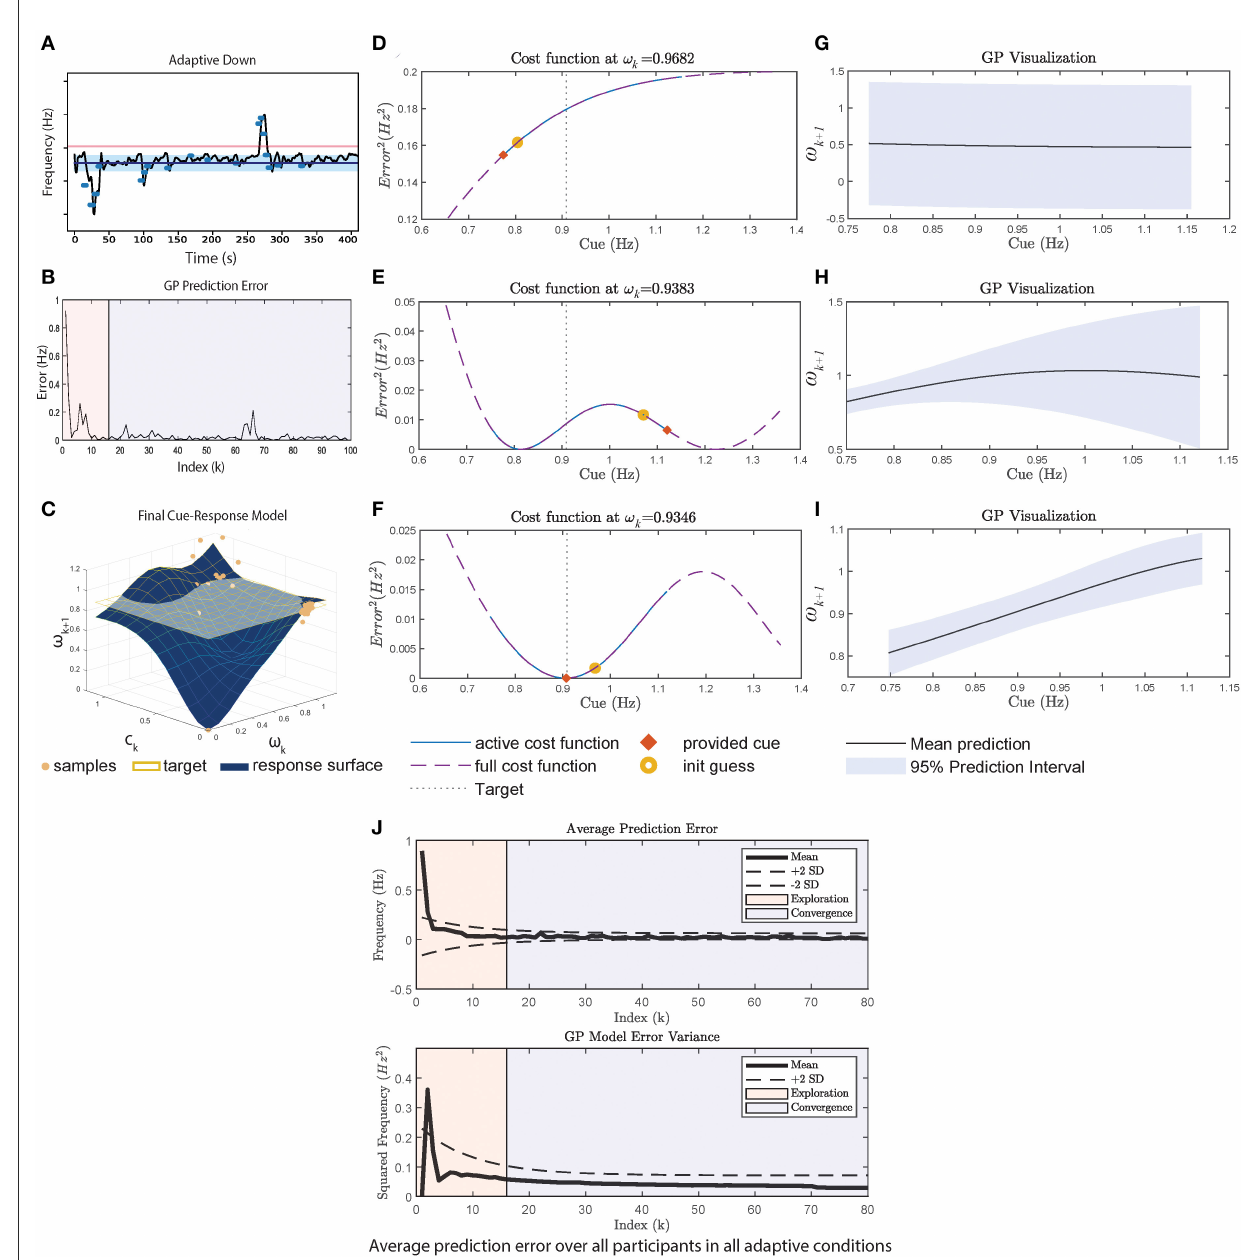
FIGURE3 A case study using data from P3 adaptive-DOWN condition in Figure 1C. (A) Cadence over time in the experiment. (B) The GP prediction error, which is calculated at every 4 strides. (C) Shows the final 3D cue response model, where the X axis is ω k , Y axis is c k and the Z axis is ω k + 1 . Samples are plotted in blue circles. ω target is plotted as the yellow horizontal plane. (D–F) Shows the cost function at the start, middle, and end of the experiment. The middle part is selected to explain the second exploration phase. The cost function is plotted over the absolute maximum and minimum cue range (dotted purple line), where the active cost function defined by Equation (4) is plotted as solid blue. The initial guess provided to the optimizer is plotted as a yellow circle, and the final provided cue is an orange square. (D) Shows the cost function at the start. (E) Shows the selection of cues given the poor representation and poor optimizer’s initial guess. (G) Shows the final shape of the cost function, which has a minimum that is close to ω target . (G–I) Shows the GP mean and variance at start/middle/end. (J) The average GP prediction error for all participants. The exploration phase (i.e., first 70 seconds) is shaded in pink. The prediction error and variance decrease significantly during exploration.